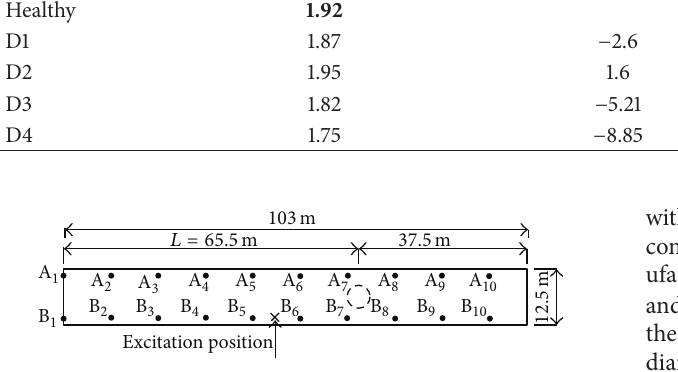
Figure 4: Location of the sensors on the bridge deck.